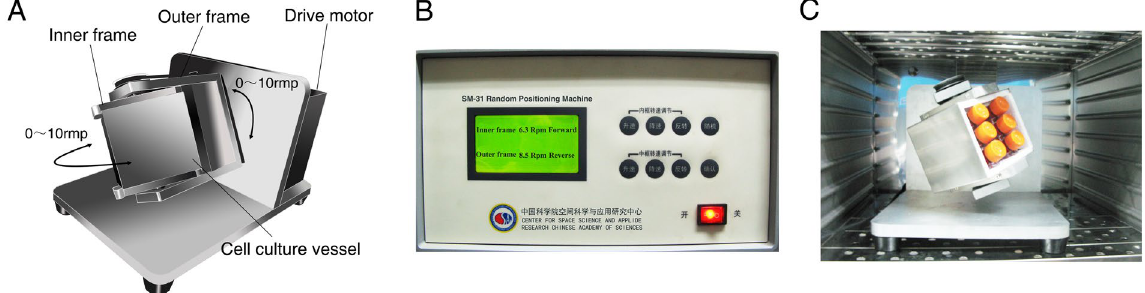
Figure 1. The random positioning machine (RPM) used in this study to generate microgravity for cultured cells. ( A ) The schematic view of the desktop RPM. ( B ) A photo of the control console operating the outer and inner frames of the RPM to rotate the cell culture vessel separately and randomly at 3-dimension in the range of 0–10 rpm. ( C ) A photo showing the RPM placed in a cell incubator. Six 50 ml-flasks with cultured ROBs sealed by aerated hydrophobic membrane were fixed on the cell culture vessel of the